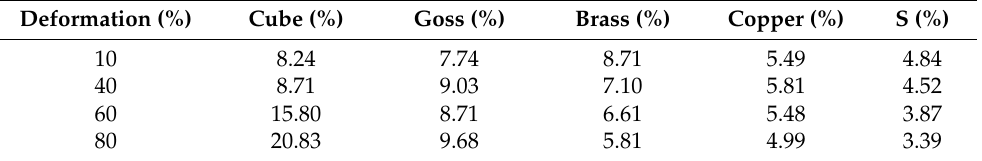
Table 3. Volume fractions of textures in alloy after different rolling deformations and annealing treatments at 470 °C for 0.5 h, calculated using the ODF (with a measurement accuracy of 0.05%). Deformation (%) Cube (%)